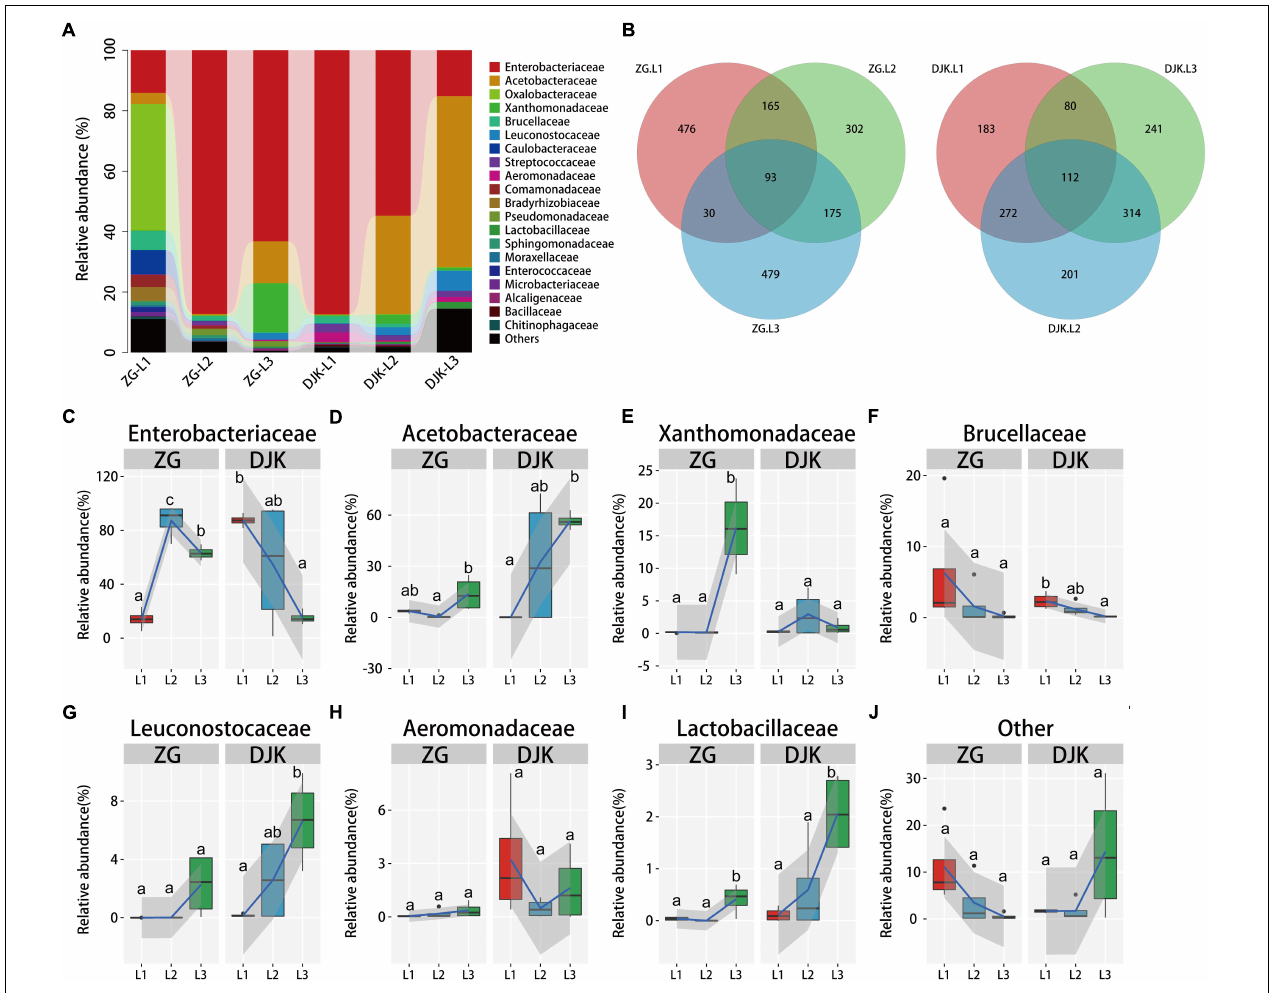
FIGURE 1 | Relative abundance of bacterial families across the lifespan of larvae. (A) Taxonomic breakdown at the family level grouped by different populations with different development stages. (B) Overlap of OTUs at the larval stage. (C–J) Boxplots showing the mean abundance of core bacteria in the larval gut. In every panel, the left side represents the population collected from Zigui (ZG, n = 4), and the right side represents the population collected from Danjiangkou (DJK, n = 4). The high, low and median data values are shown in boxplots, and the lower and upper edges of every box represent the first and third quartiles, respectively. Multiple comparisons were performed in the two groups separately. Different letters indicate a significant difference between different instars in each group ( p < 0.05, one-way ANOVA, Tukey post hoc test). The curve fitting was created using the “ggplot2” package in R statistical analyses. The lines show median values per region window, and the shaded area denotes the estimated 95% confidence